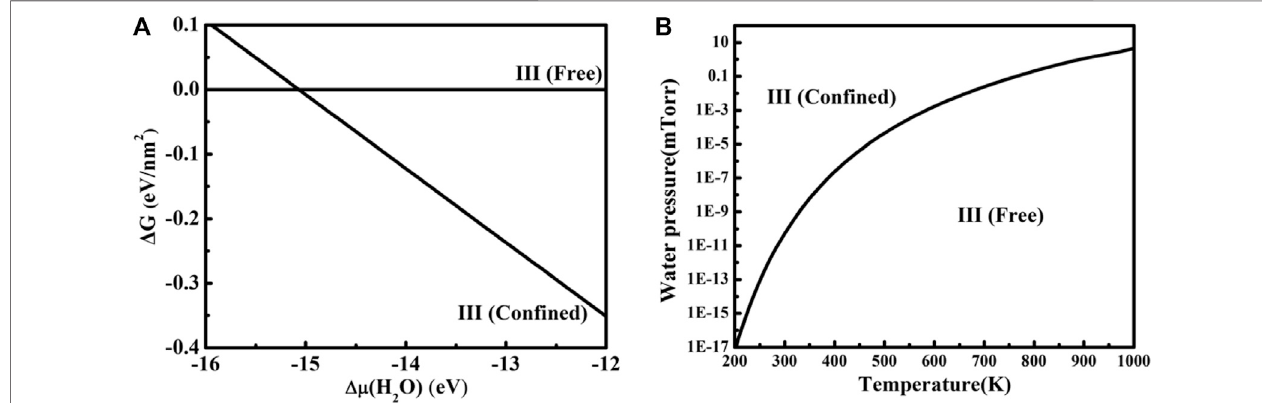
FIGURE 4 | (A) Gibbs free energy change Δ G for freestanding ice III and the CaF 2 (111)/ice III/graphene system versus the chemical potential change of the gas water molecule. (B) The phase diagram for free standing ice III and the CaF 2 (111)/ice III/graphene system under different P and T.